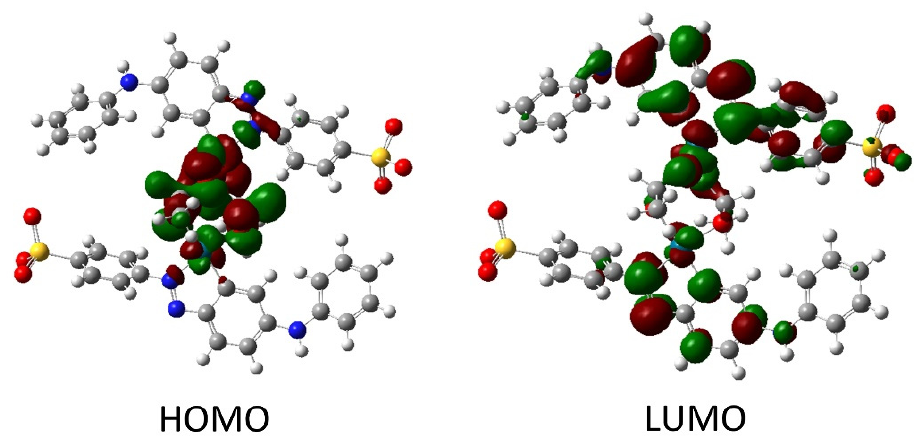
Figure 5. The HOMO and LUMO after DFT calculation for TR-Pd 2 structure.